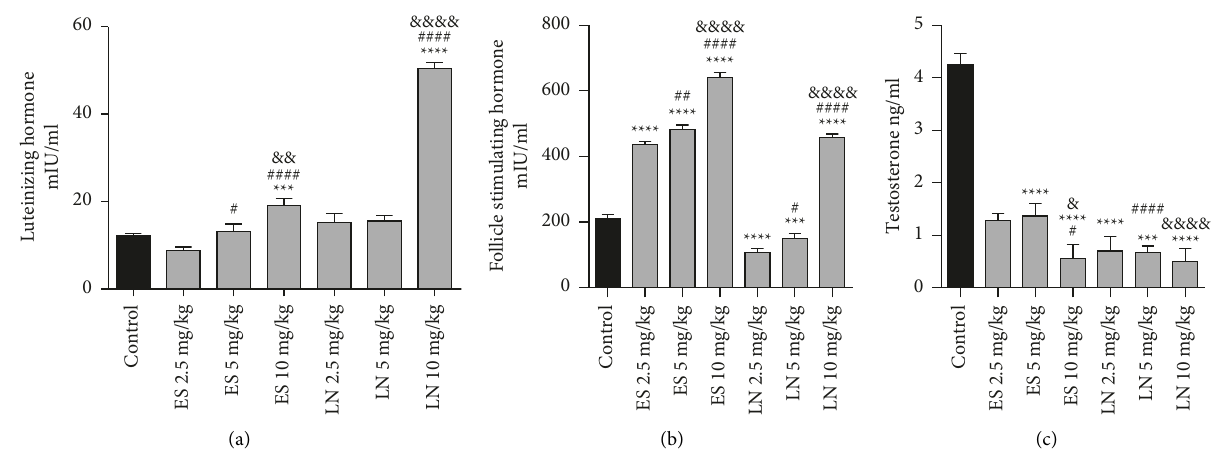
Figure 3: Effect of esomeprazole (ES) and lansoprazole (LN) treatment on sex hormones in male rats ∗∗∗ and ∗∗∗∗ showed significant results at P < 0 . 001 and P < 0 . 0001 contrary to control group. # and #### showed significant results at P < 0 . 05 and 0.0001 on contrary to eso- meprazole/lansoprazole 2.5 mg/kg/day. & , && , and &&&& showed significant results at P < 0 . 05 , 0 . 01, and 0.0001 on contrary to esomeprazole/ lansoprazole